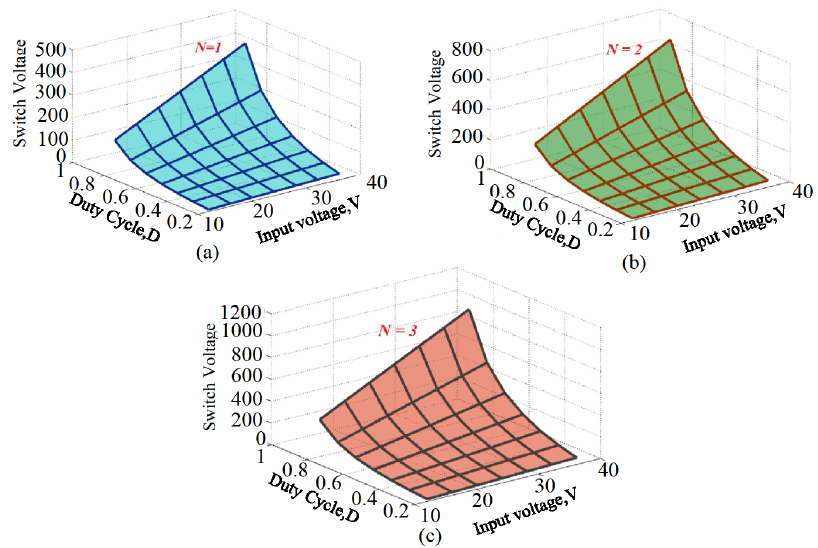
Figure 5. Analysis on switch voltage stress ( a ) N = 1 ( b ) N = 2 ( c ) N = 3. Table 2. Correlations for 1, 2, . . . , N expander cell Table 2. Correlations for 1,2,…, N expander cell configuration.